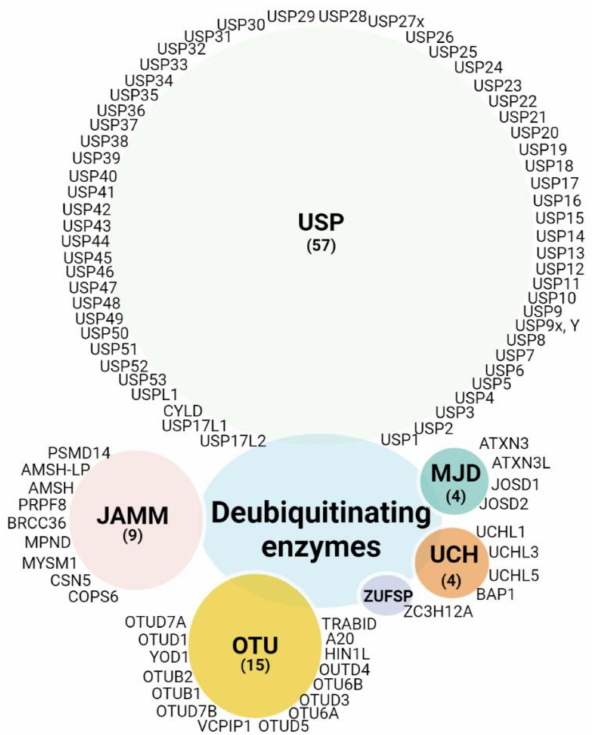
Figure 2. DUB categories: DUBs currently encoded in the human genome are clustered in five classes depicted in different color schemes. Of the six subfamilies, five are cysteine proteases: ubiquitin C-terminal hydrolases (UCH), ubiquitin-specific proteases (USP), zinc finger-containing ubiquitin peptidase (ZUP1), Machado-Joseph disease proteases (MJD, Josephins), and ovarian tumor proteases (OTU), and a one family belongs to the Jab1/Pab1/MPN domain-associated zinc metalloproteases (JAMM). (Created with BioRender.com, (Created with BioRender.com, accessed 20 June